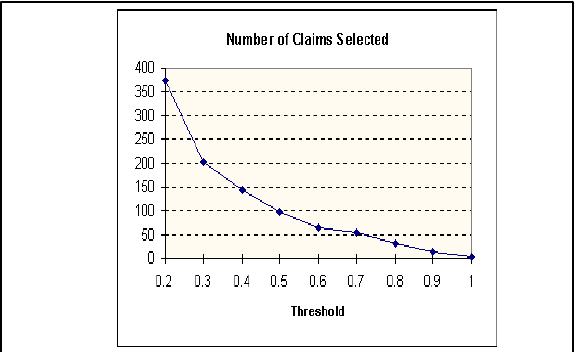
Figure 1: Because the NN (Fuzzy Logic) FD system associates each claim with a number between 00 and 01, the number of claims selected for scrutiny depends on the